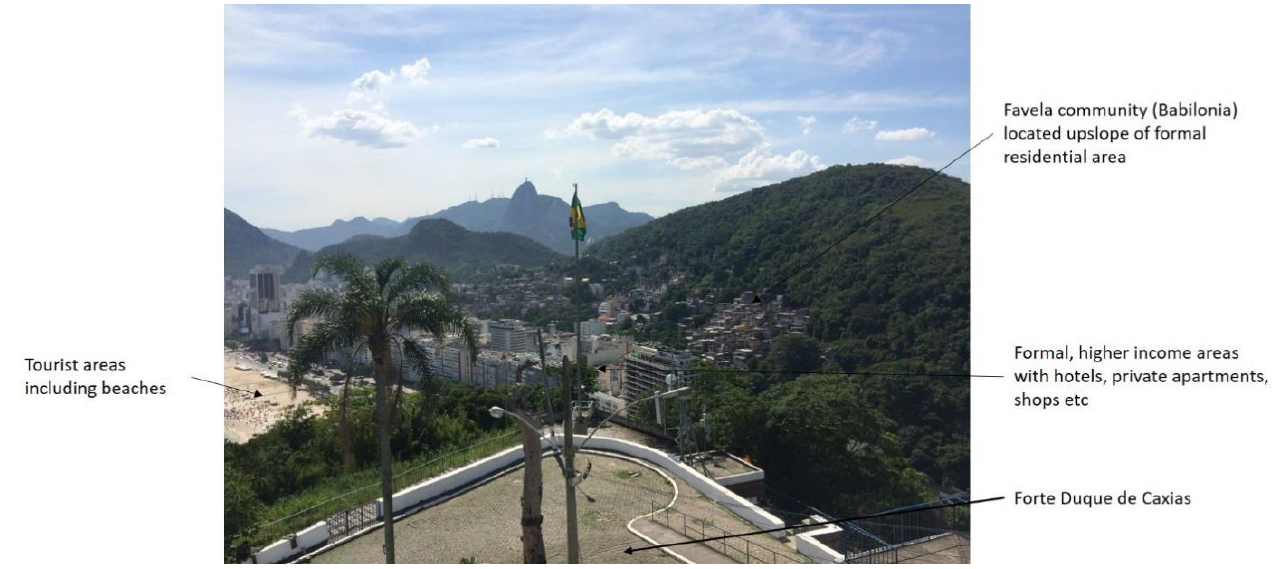
Figure 7. Location of some of Rio de Janeiro favelas.